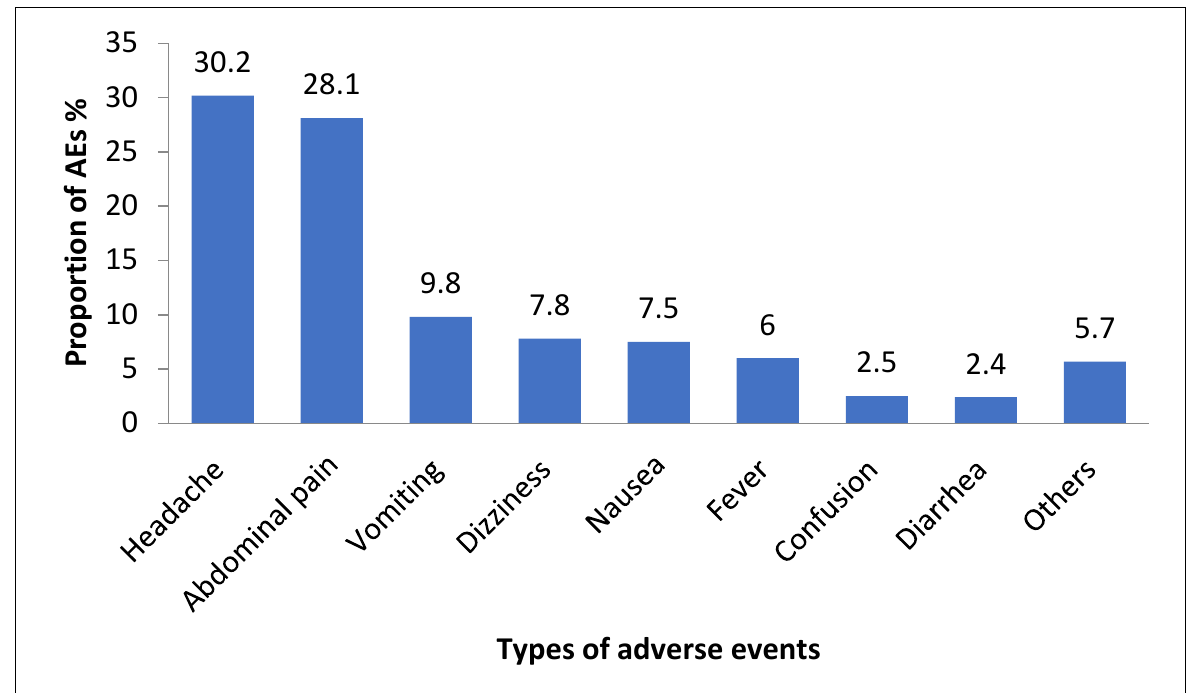
Figure 3. Proportions of AEs stratified by type of AEs.